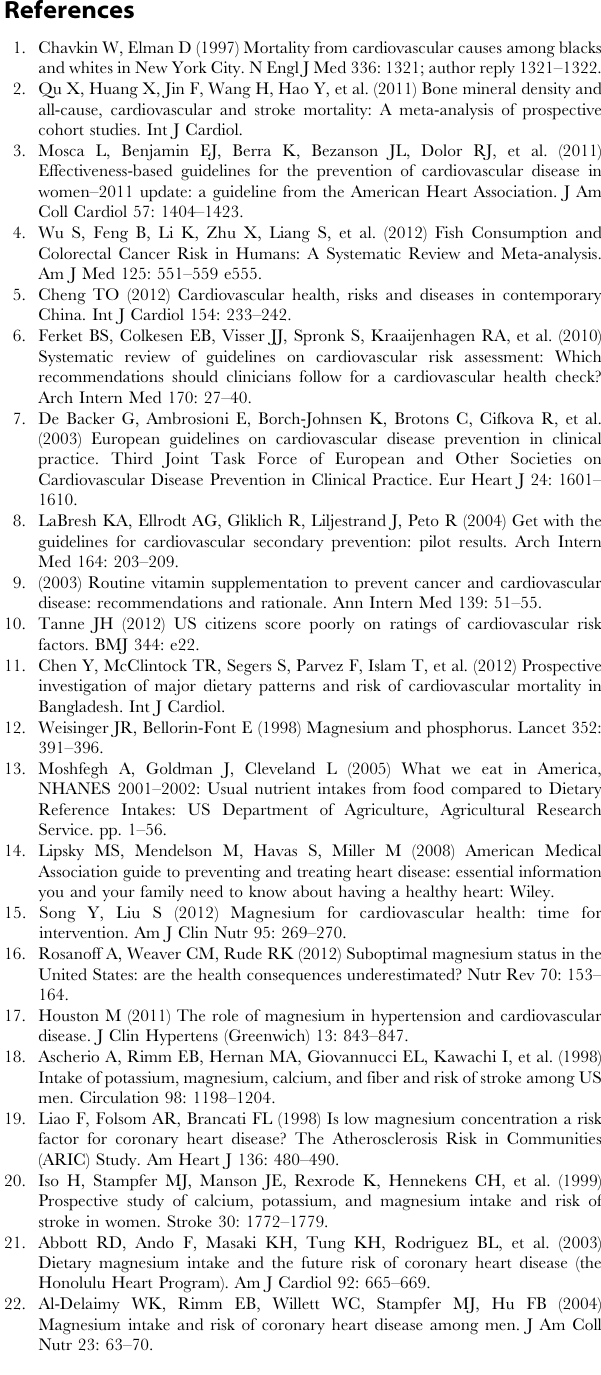
Figure S1 Flowchart of the study selection process. Figure S2 Trim and fill funnel plot for meta-analysis of the association between dietary magnesium intake